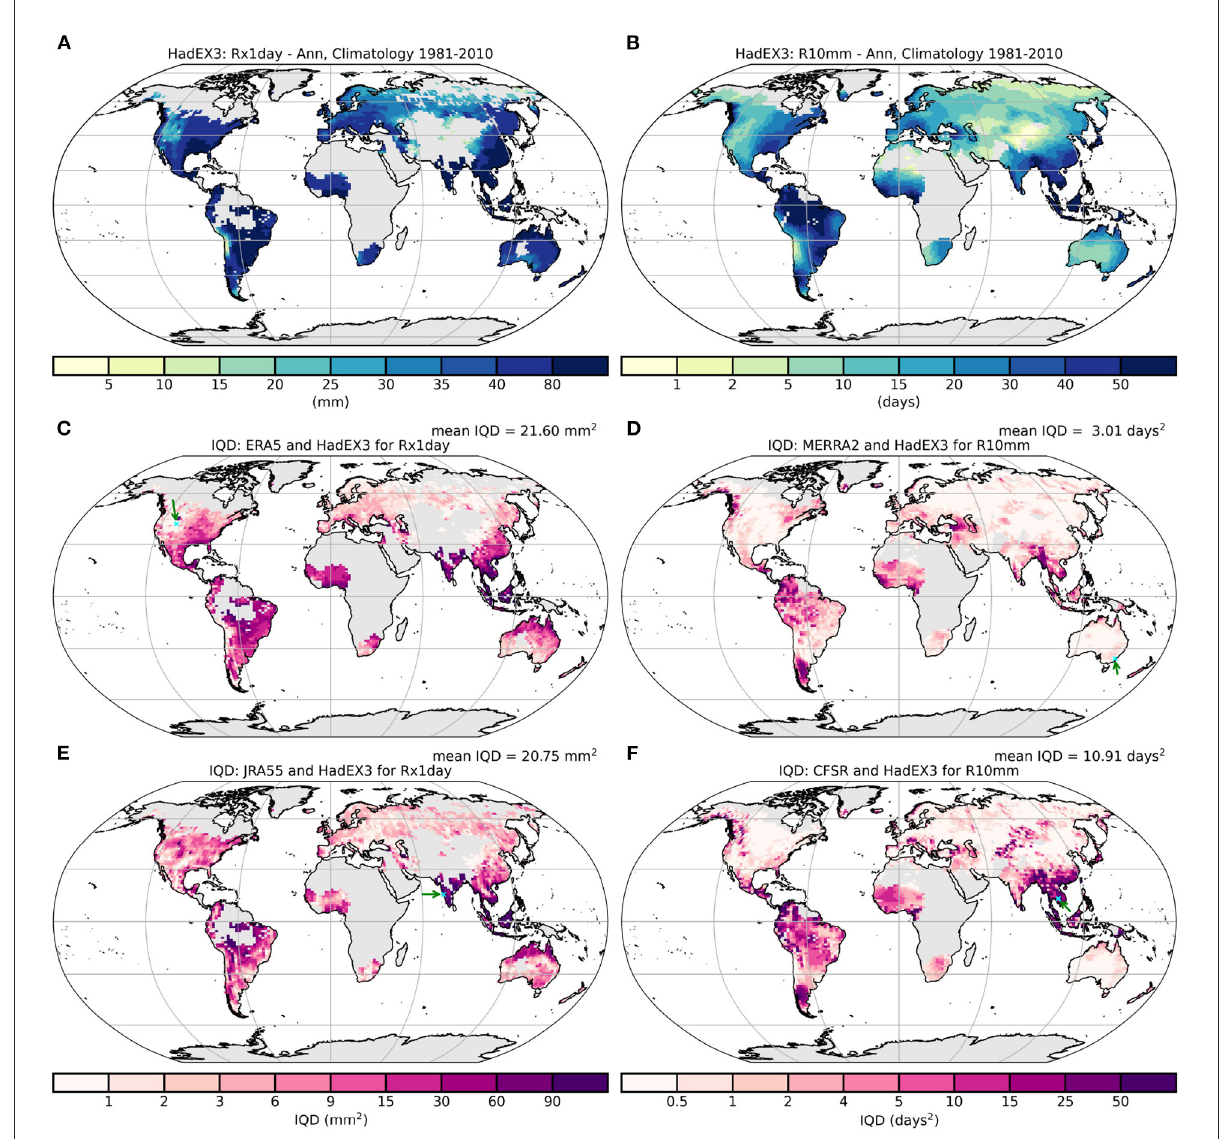
FIGURE10 The 1981–2010 climatology maps for (A) Rx1day, and (B) R10mm, using the same selection criteria for the maps of trends and IQDs. The IQD maps for Rx1day with (C) ERA5, and (E) JRA-55, and R10mm with (D) MERRA-2, and (F) CFSR. Small (so as not to distract from the underlying values) blue crosses mark the locations of grid boxes presented in Figure A2, which are also indicated by a green arrow [ (C) North America, (D) south-eastern Australia, (E) western India, (F) south-eastern